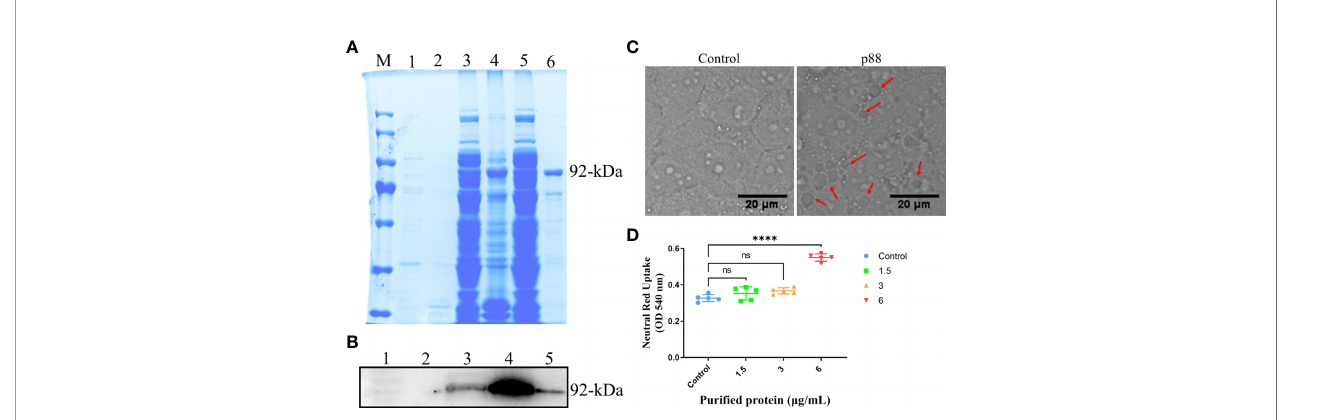
FIGURE 3 | The expression and activity veri fi cation of p88. The Escherichia coli ( E. coli ) extracts containing recombinant VacA (p88) were analyzed using 8% sodium dodecyl sulfate-polyacrylamide gel electrophoresis (SDS-PAGE), and stained with coomassie brilliant blue. M, marker; 1, soluble fraction before induction; 2, insoluble fraction before induction; 3, soluble fraction after induction; 4, insoluble fraction after induction; 5, fl ow-through; 6, elution. The band in lane 6 labeled with 92-kDa indicates the puri fi ed p88 (A) . p88 was immunoblotted with a VacA antibody. 1, soluble fraction before induction; 2, insoluble fraction before induction; 3, soluble fraction after induction; 4, insoluble fraction after induction; 6, elution. The band in lane 5 labeled with 92-kDa indicates the puri fi ed p88 (B) . Representative images (Scale bar, 20 m m) of vacuoles (indicated by the red arrows) in GES-1 cells treated with p88 (6 m g/ml) for 4 h (C) . The vacuolating activity of different concentrations of p88 was measured by a neutral red uptake assay (D) . The asterisks indicate signi fi cant differences from the control. n = 5. **** p <0.0001. ns, no signi fi